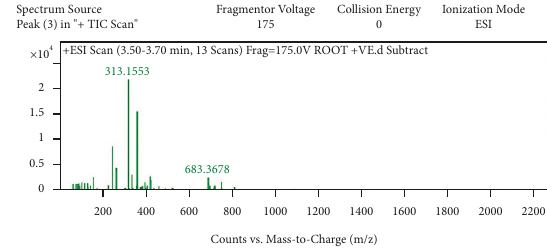
Figure 6: Mass spectra of peak 3.